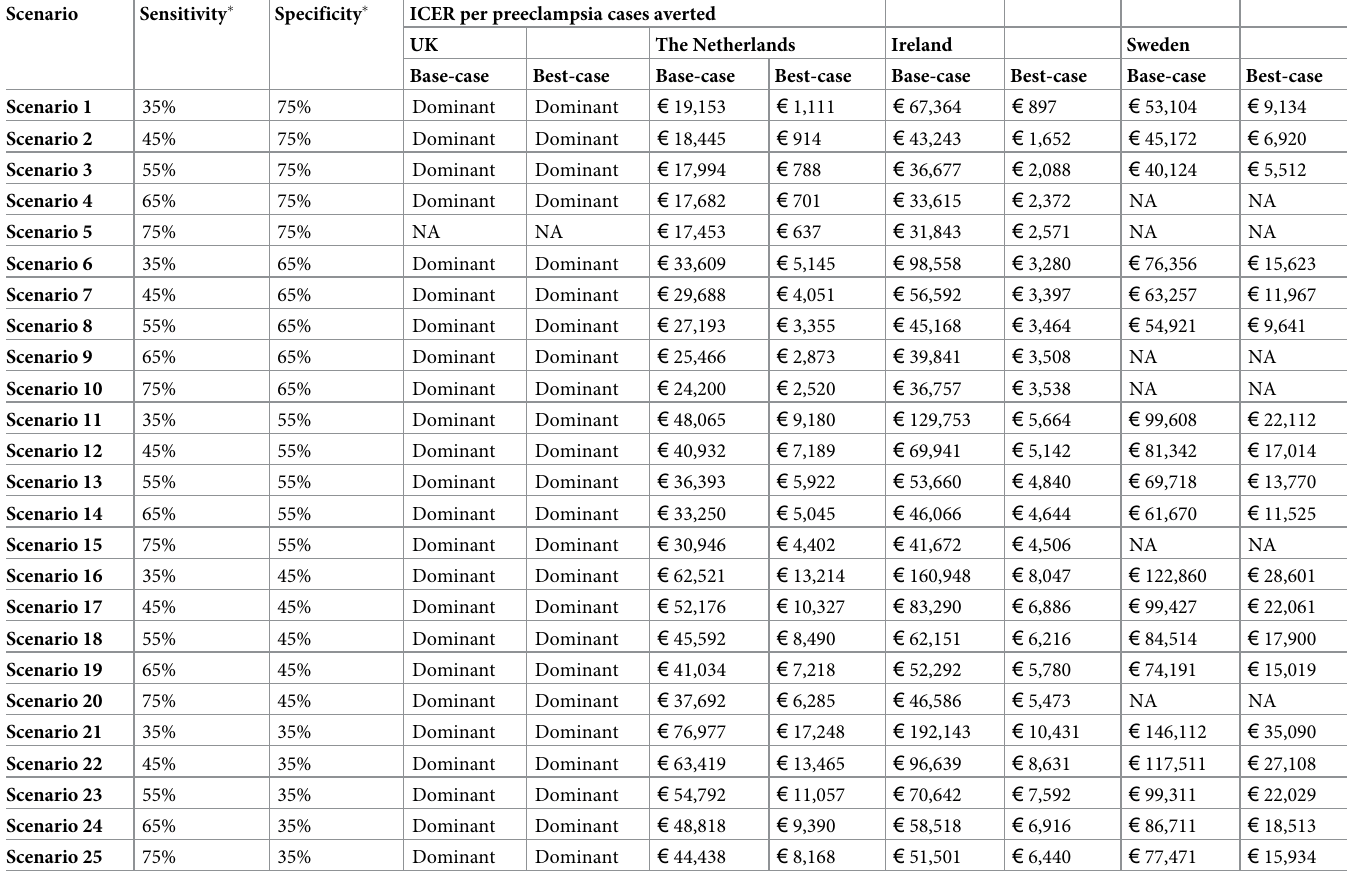
Table 3. Cost-effectiveness of new test strategy versus current screening strategy in exploratory scenario analyses in four participating countries, i.e. UK, The Neth- erlands, Ireland and